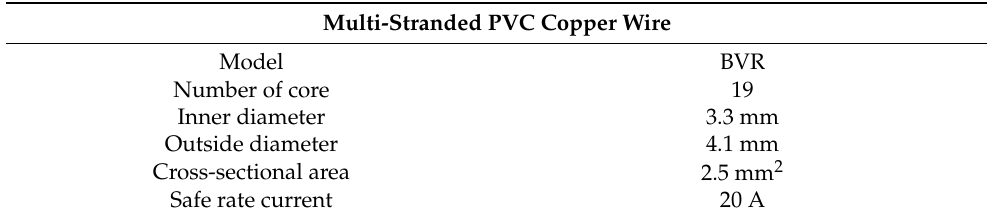
Table 1. Multi-stranded PVC copper wire specification